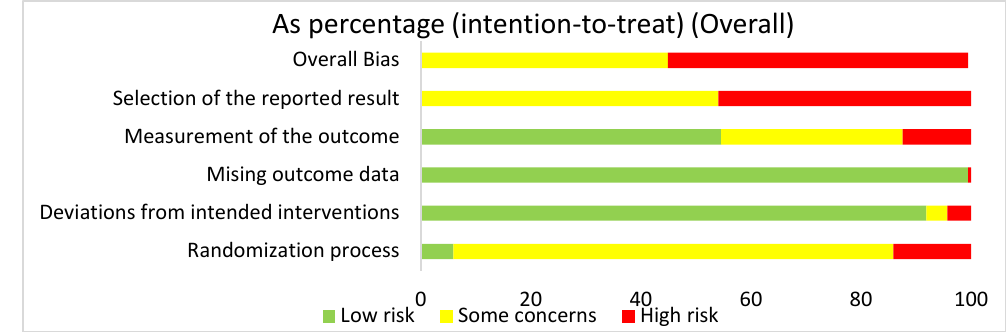
Figure 2. The overall risk of bias for all the articles in the dataset was a high risk of bias (54.6%) and some concerns (44.8%). The selection of the reported result had a high risk of bias (45.9%) and some concerns (54.1%). The measurement of the outcome had a high risk of bias (12.4%), some concerns (33%), and low risk of bias (54.6%). The missing outcome data domain had a low risk of bias (99.5%) and a high risk of bias (0.5%). Deviations from intended interventions had a low risk of bias (91.9%), some concerns (3.8%), and high risk of bias (4.3%). The randomization process had a high risk of bias (14.1%), some concerns (80%), and low risk of bias (5.9%).